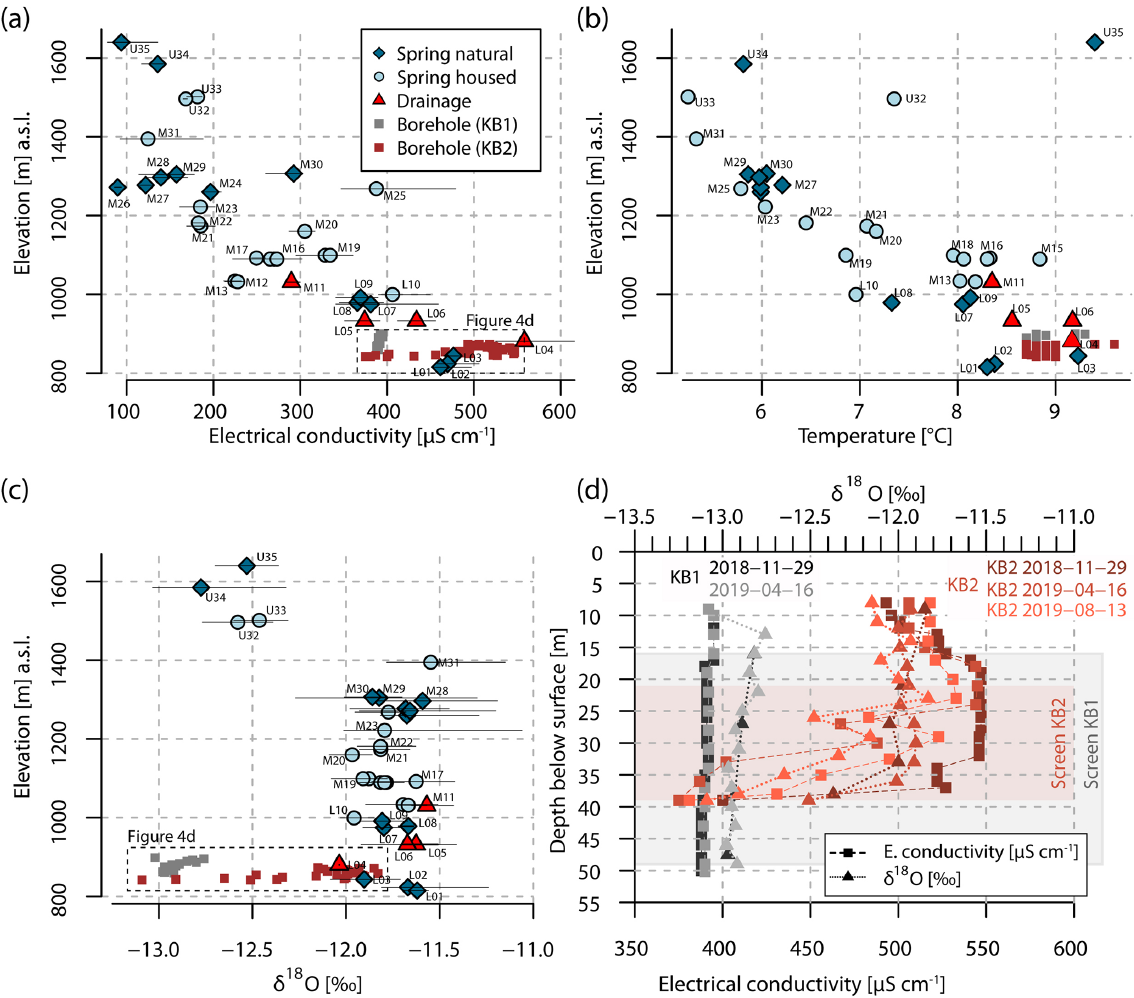
Figure 4. Diagrams showing mean values of EC (a) , T (b) , and δ 18 O (c) of monitored springs and boreholes. Thin black lines in (a) and (c) indicate the observed range between minimum and maximum values. EC and δ 18 O measured at different depths in the KB1 and KB2 wells are shown in (d) . The groundwater level during sampling can be obtained from Fig.